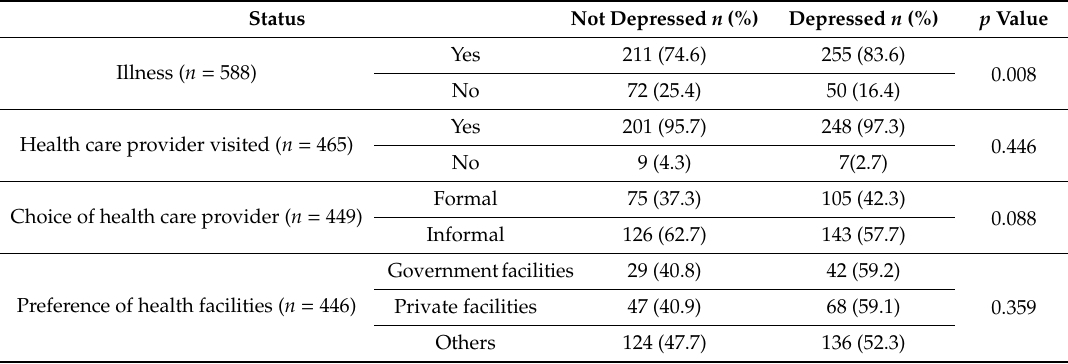
Table 3. Illness, visit of health care provider and choice of health care provider and facility of the family member (any family member, including the mothers) in the last one month by depression status.